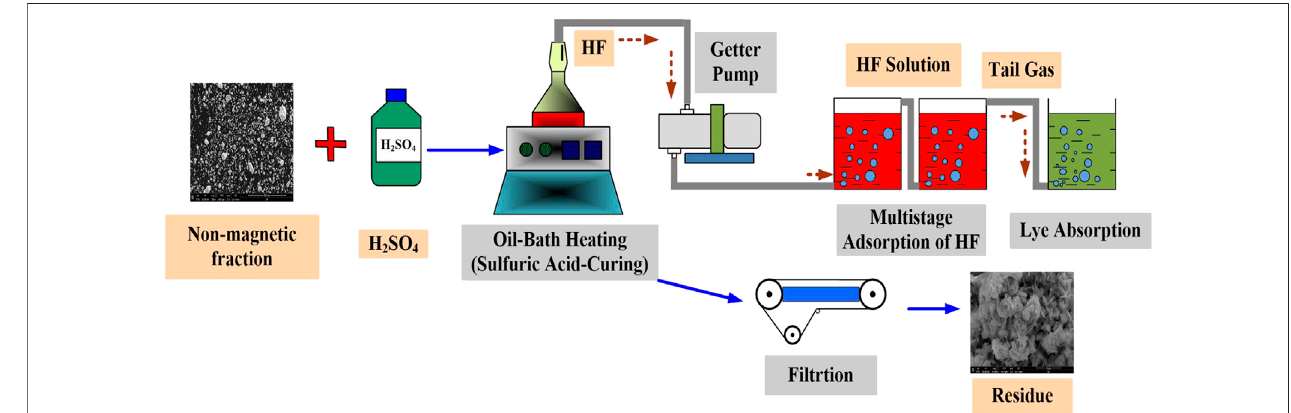
FIGURE 3 | Process of fl uoride sulfate